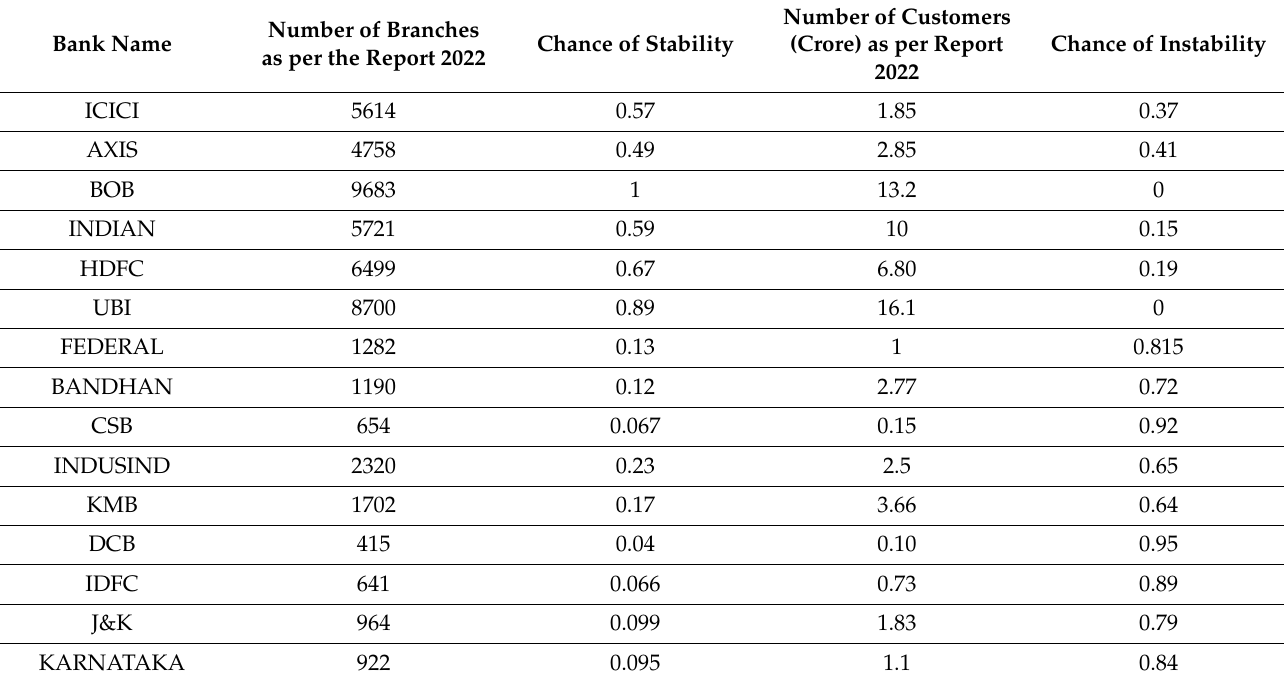
Table 3. List of banks with parameters(Number of Branches, Number of Customers).